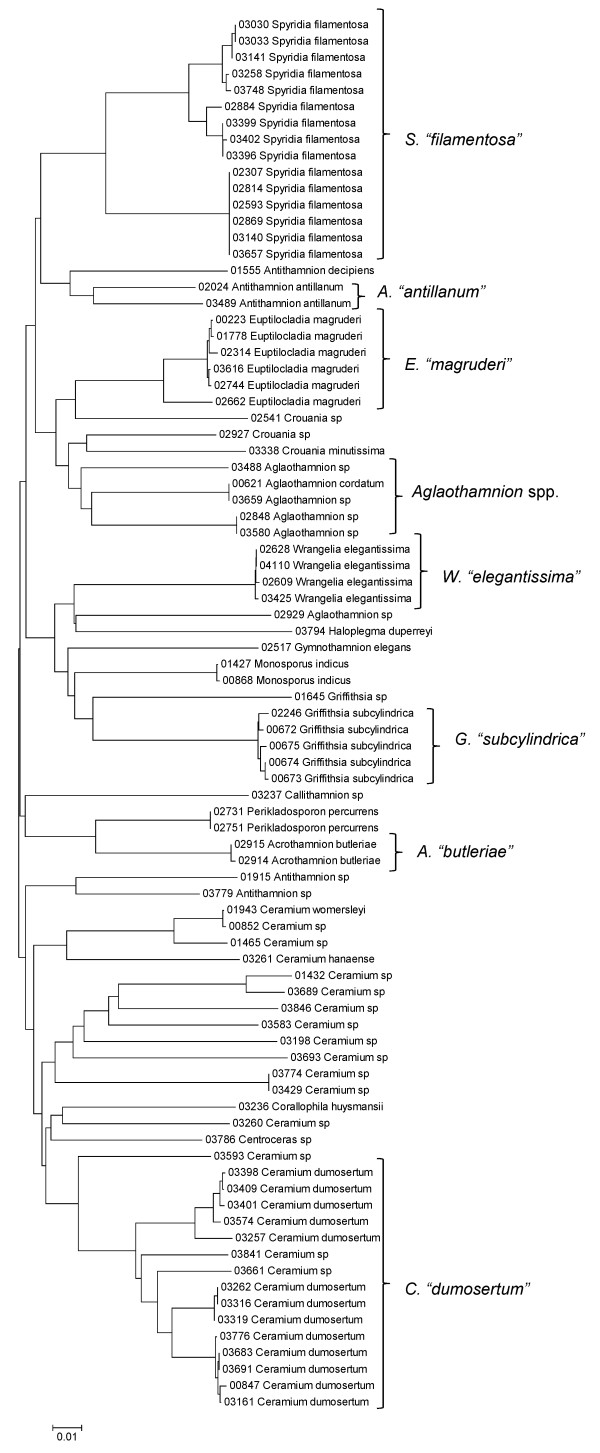
Neighbor-joining tree of COI sequences of the families Callithamniaceae, Ceramiaceae, Spyridiaceae and Wrangeliaceae of the order Ceramiales. Sequence diversity based on the COI mitochondrial marker for surveyed Rhodophyta specimens belonging to the families Callithamniaceae, Ceramiaceae, Spyridiaceae and Wrangeliaceae of the order Ceramiales. Neighbor-joining tree is based on the Maximum Composite Likelihood nucleotide model in MEGA 4.0. Scale bar = substitutions per site.